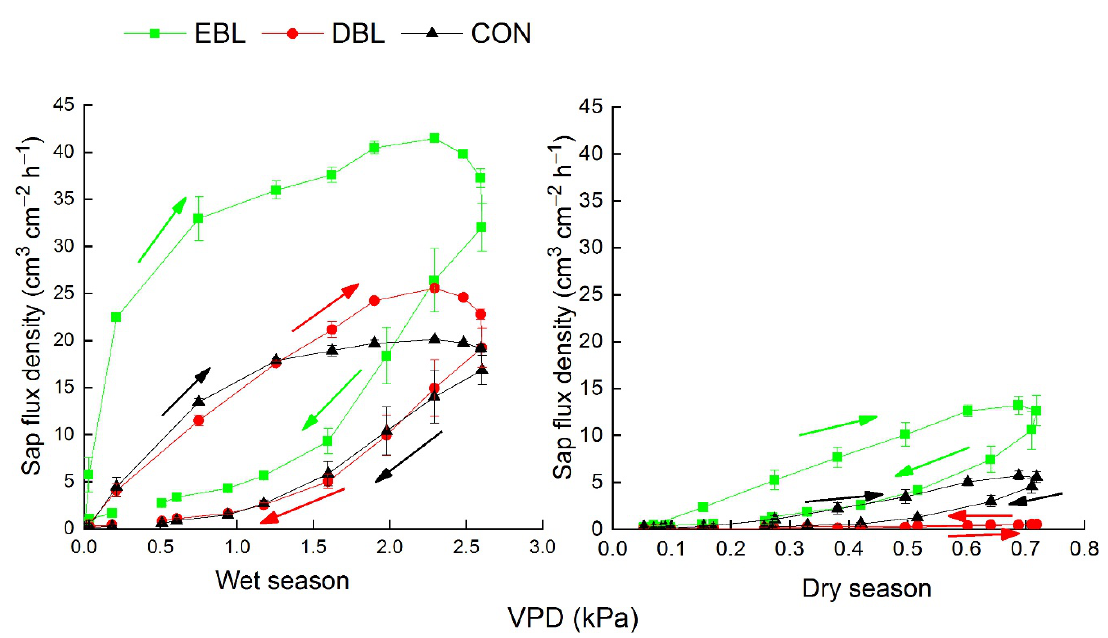
Figure 6. Diurnal sap flux densities of evergreen broad-leaved trees (EBL), deciduous broad-leaved trees (DBL), and conifers (CON) response to VPD. Data were collected from sunny days in wet (from 25 July 2017 to 27 July 2017) and dry (from 17 January 2018 to 19 January 2018) seasons. The arrows show the chronological order.